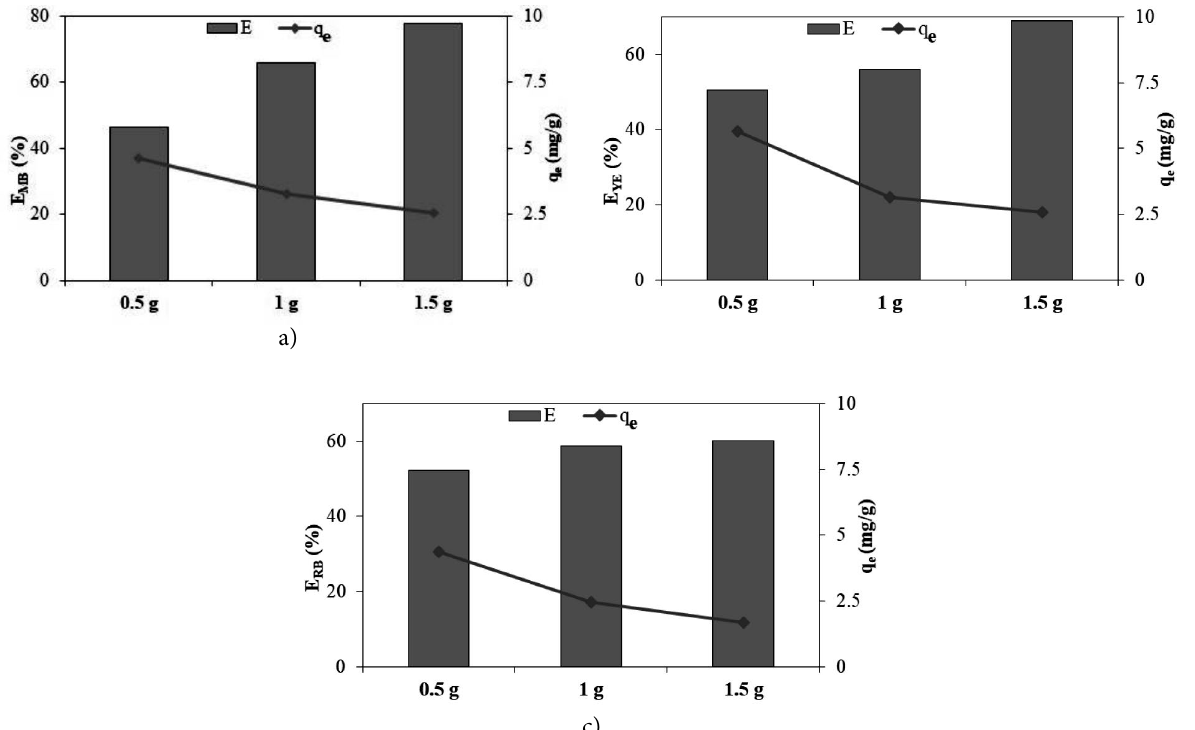
Fig. 2. Removal efficiency of MB (a), EY (b) and RB (c) adsorption onto CNAC surface at different adsorbent doses ( C o = 100 mg/L, m = 0.5 - 1.5 g, particle size = <0.5 mm, stirring rate = 75 rpm, V = 50 mL; time = 300